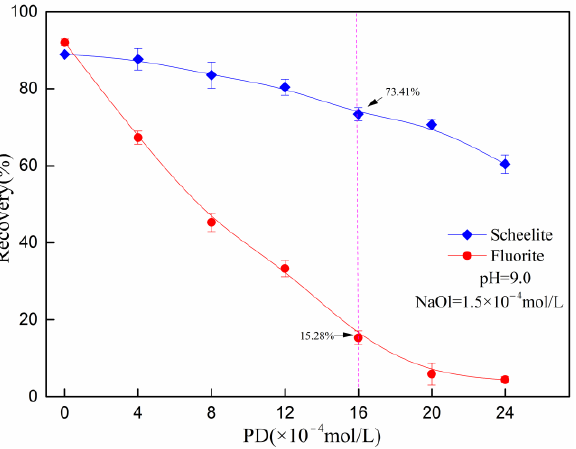
Figure 4. Recovery of scheelite and fluorite as a function of PD (NaOl: 1.5 × 10 −4 mol/L; pH: 9.0).